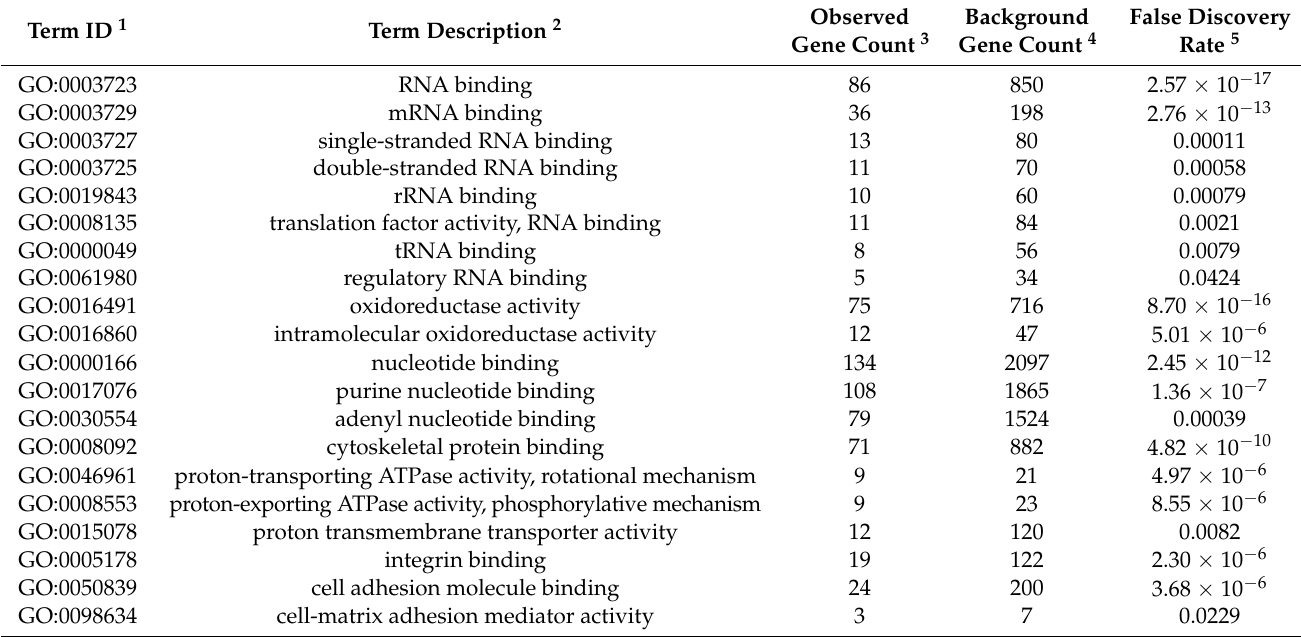
Table 2. Selected molecular functions altered in HF-MSS, based on Gene Ontology enrichment analysis.